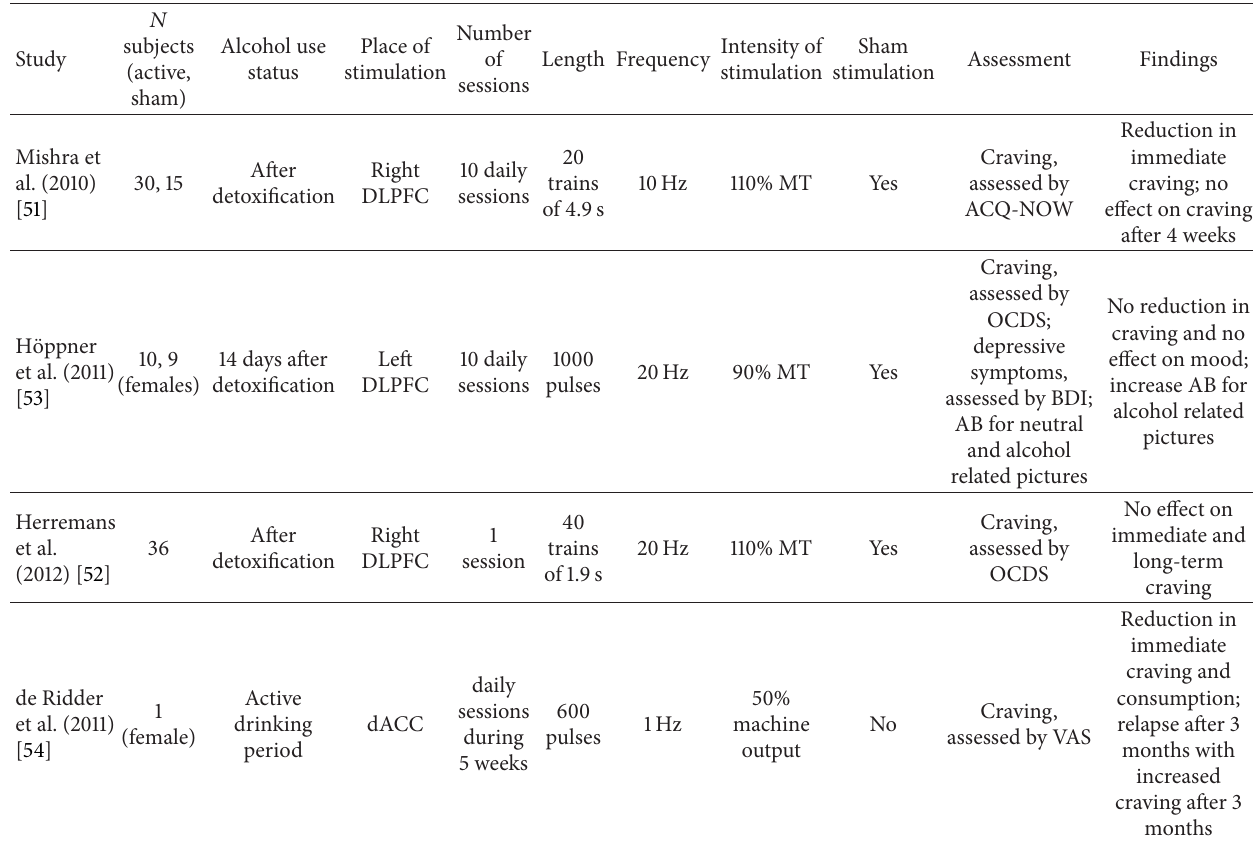
Table 2: Summary of the studies on rTMS in the treatment of alcohol